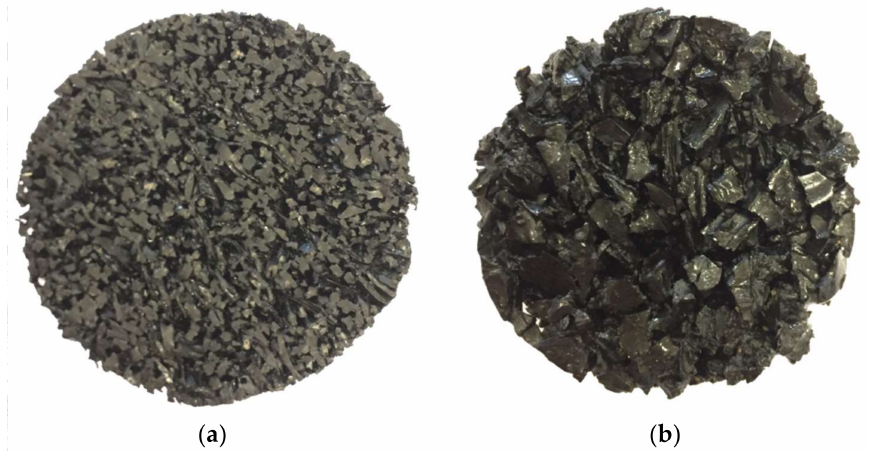
Figure 2. Sample sections of ( a ) Regupol ® 6010 SP shockpad manufactured by Berleburger. ( b ) Holywell shockpad laid in-situ on Loughborough University